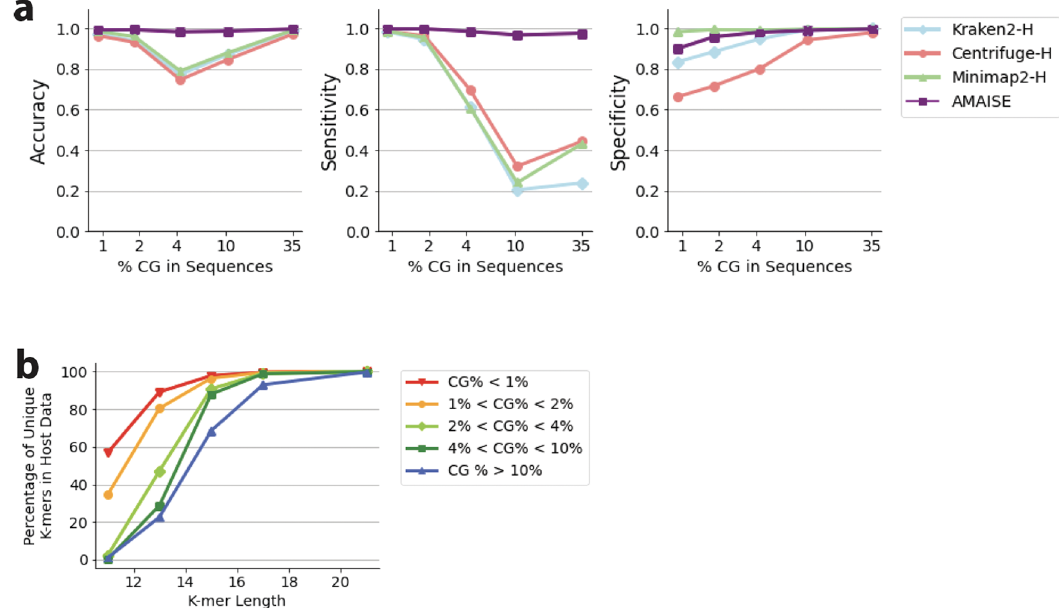
Fig. 7 Performance of AMAISE, Kraken2-H, Centrifuge-H, and Minimap2-H across samples that varied in terms of ‘ CG ’ percentage within the sequences in the sample. a The performance of AMAISE remains stable across ‘ CG ’ percentages (<1%, between 1% and 2%, between 2% and 4%, between 4% and 10%, and above 10%). Kraken2, Centrifuge, and Minimap2 ’ s sensitivity drops below 50% when the ‘ CG ’ percentage is above 4%. b As the percentage of ‘ CG ’ in sequences increases, the number of unique 11-mers, 13-mers, and 15-mers in the host data decreases. This suggests that classifying data with lower percentages of ‘ CG ’ is an easier task than classifying data with higher percentages of ‘ CG ’